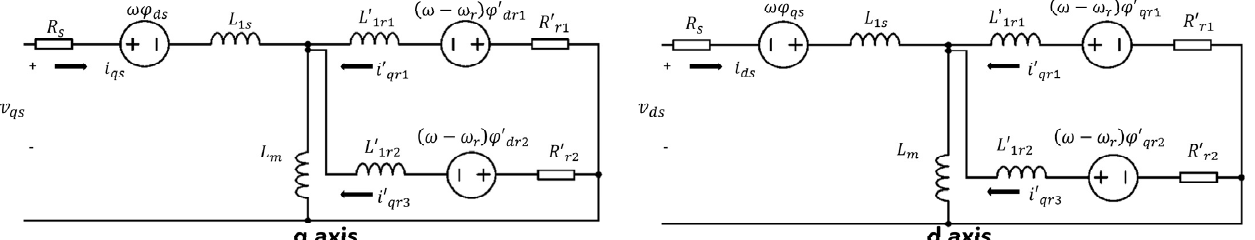
Figure 8. Equivalent circuit for double cage induction machine.